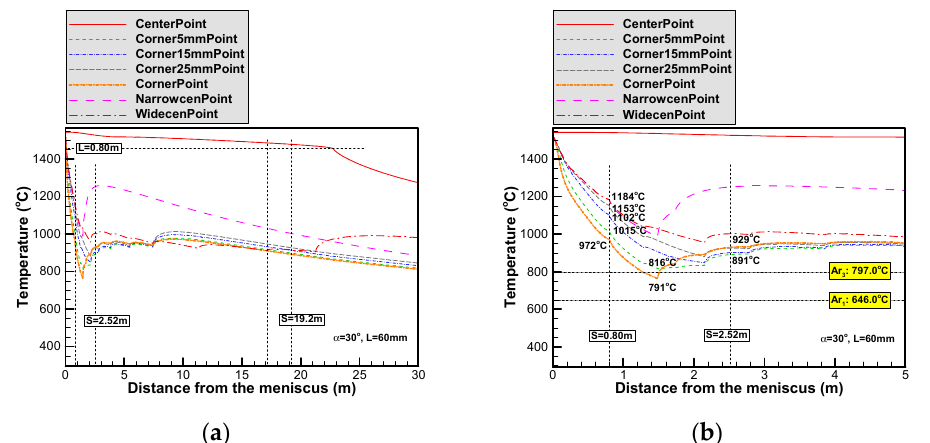
Figure 12. Temperature distribution under intensive cooling in foot roller zone of the chamfered slab. ( a ) The whole process of slab solidification, ( b ) enlarged view of mould and bending section.